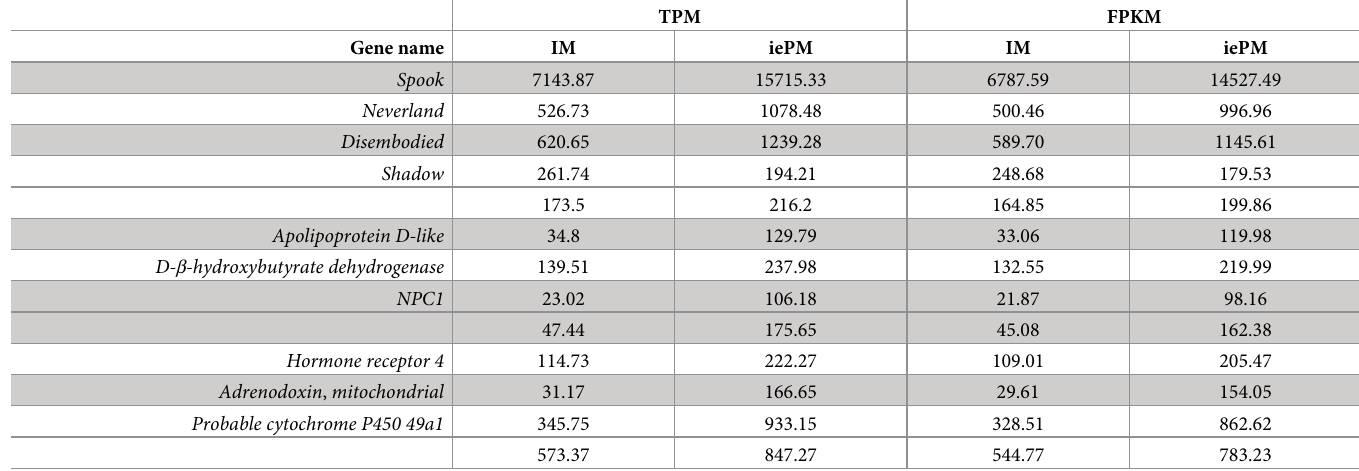
Table 4. Abundance of genes in transcript per million (TPM) and their corresponding fragments per kilo base per million mapped reads (FPKM) involved in ecdys- teroid synthesis, cholesterol uptake and transport in the YO transcriptomes of C. sapidus at intermolt (IM) and induced early premolt (iePM). When a gene pre- sented several transcripts, the abundance of both transcripts is shown.